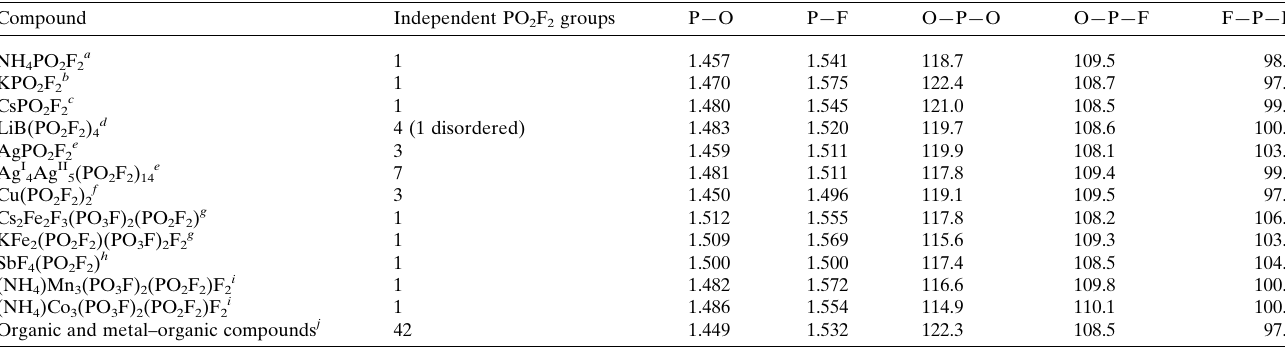
Table 3 Averaged bond lengths (A˚ ) and angles ( (cid:4) ) in PO 2 F 2 tetrahedra present in several compounds. Compound